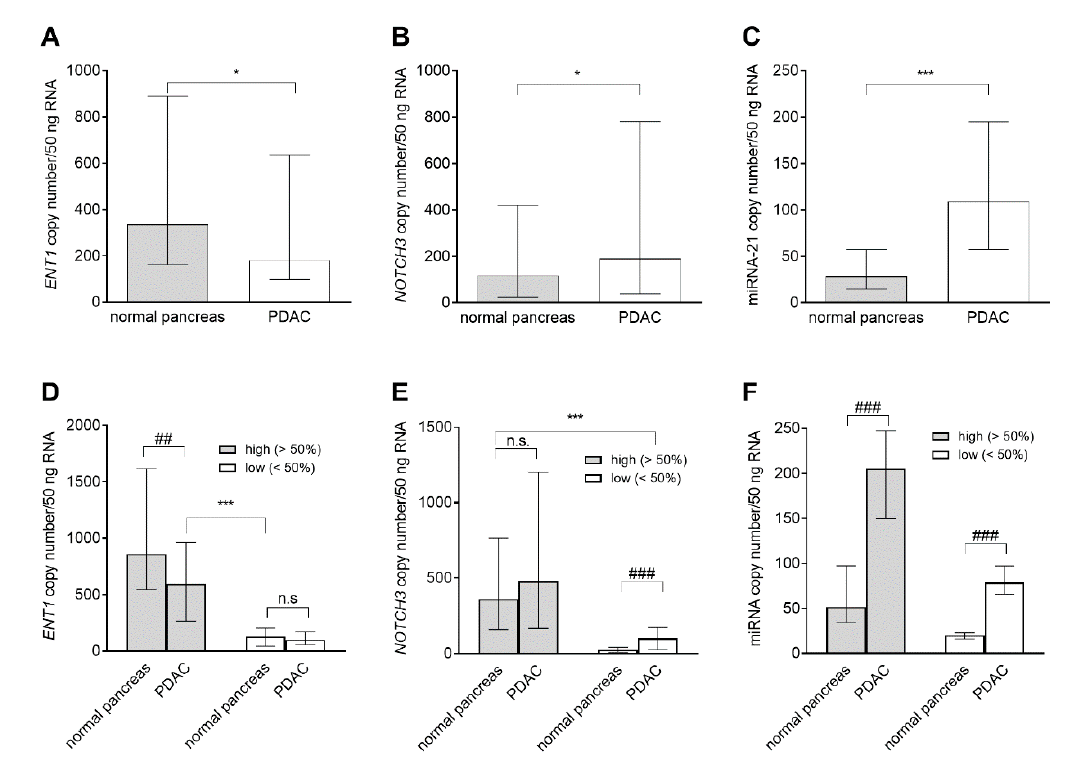
Figure 7. Comparison of mRNA expression of ENT1, NOTCH3 mRNA, and miR-21 in PDAC and normal pancreas. We compared overall expression between normal pancreas and tumor tissues in the whole sample cohort ( A – C ) and subsequently, in subpopulations (high > 50% and low < 50%) sorted according to the median of the respective molecule expression in healthy tissue ( D – F ). The data are presented as median of copy number / 50 ng of total RNA with the interquartile range. The nonparametric unpaired Mann–Whitney test was used to evaluate di ff erences in overall expression between the PDAC and normal pancreas ( A – C ), n = 65, and to compare overall expression in respective subgroups ( D – F ); significance was denoted * p < 0.05 and *** p < 0.001. Statistical significance between expression in PDAC and normal pancreas in subgroups defined by medians ( D – F ) was evaluated using the Wilcoxon matched-pair signed-rank test: n = 37 (high > 50%) and n = 27 (low < 50%) for ENT1 ( D ); n = 40 (high > 50%) and n = 34 (low < 50%) for NOTCH3 ( E ), and n = 31 (high > 50%) and n = 33 (low < 50%) for miR-21 ( F ); ## p < 0.01 and ### p <